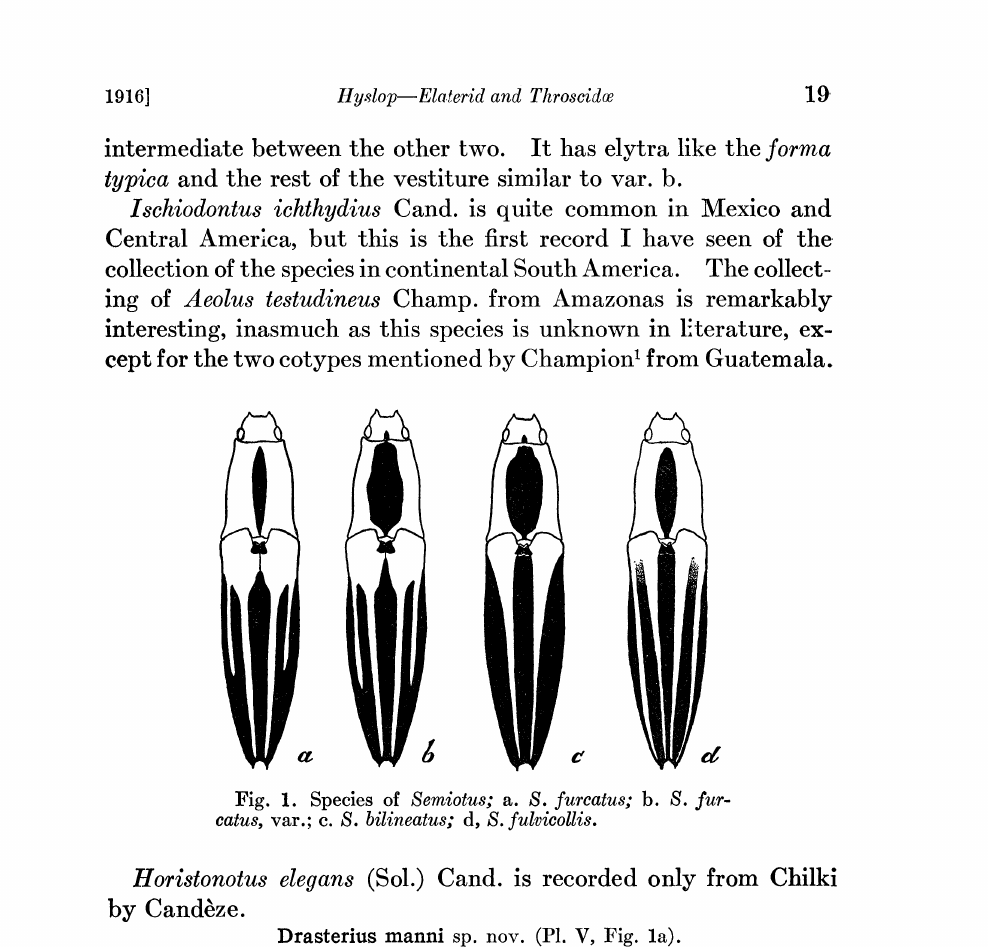
Fig. 1. Species of Semiotus; a. S. furcatus; b. S. fur- catus, var.; c. S. bilineatus; d, S.